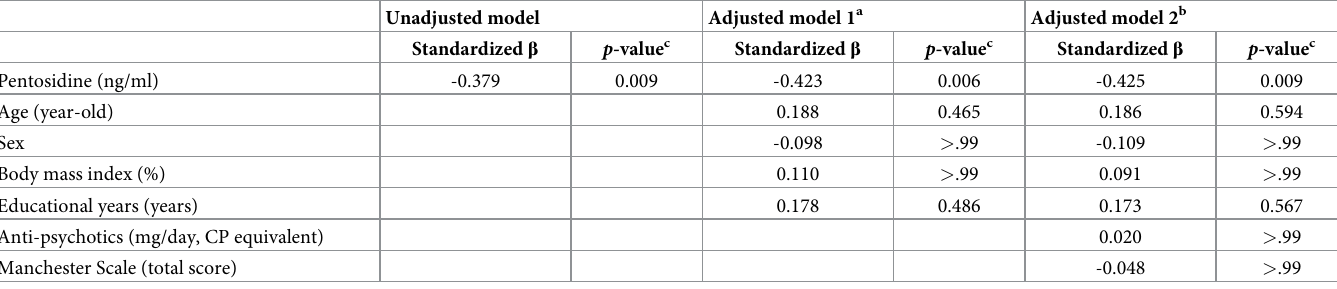
Table 2. Association between pentosidine and processing